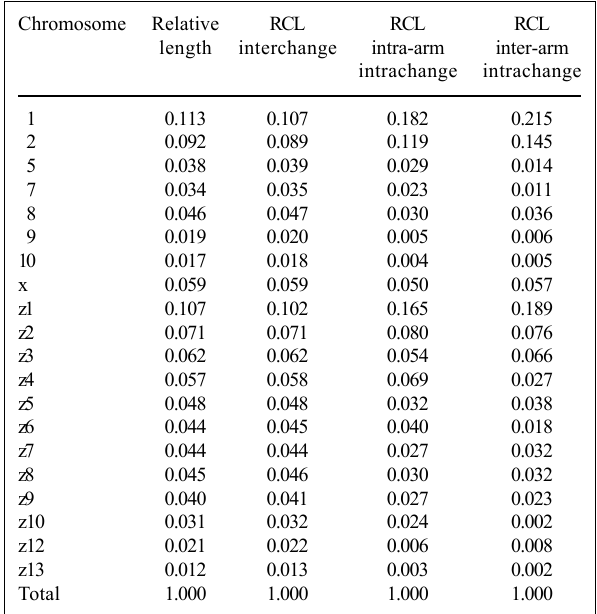
Table II - Relative length and relative corrected lengths (RCLs) for interchanges, intra-arm intrachanges and inter- arm intrachanges of CHO chromosomes.